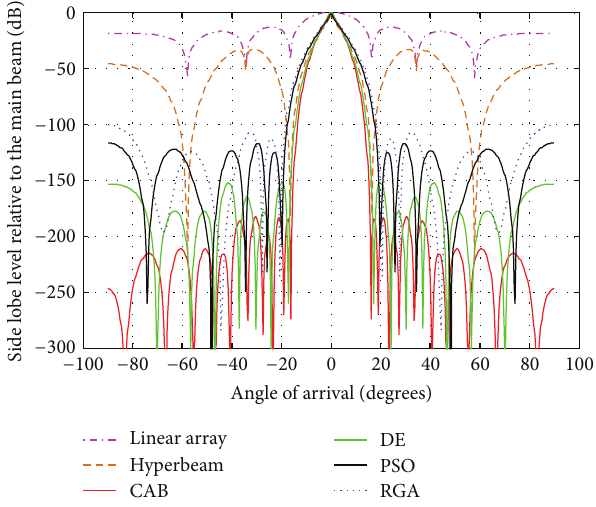
Figure 4: Best array pattern found by CAB for the 10-element array with improved SLL and FNBW at 𝑢 = 0.5